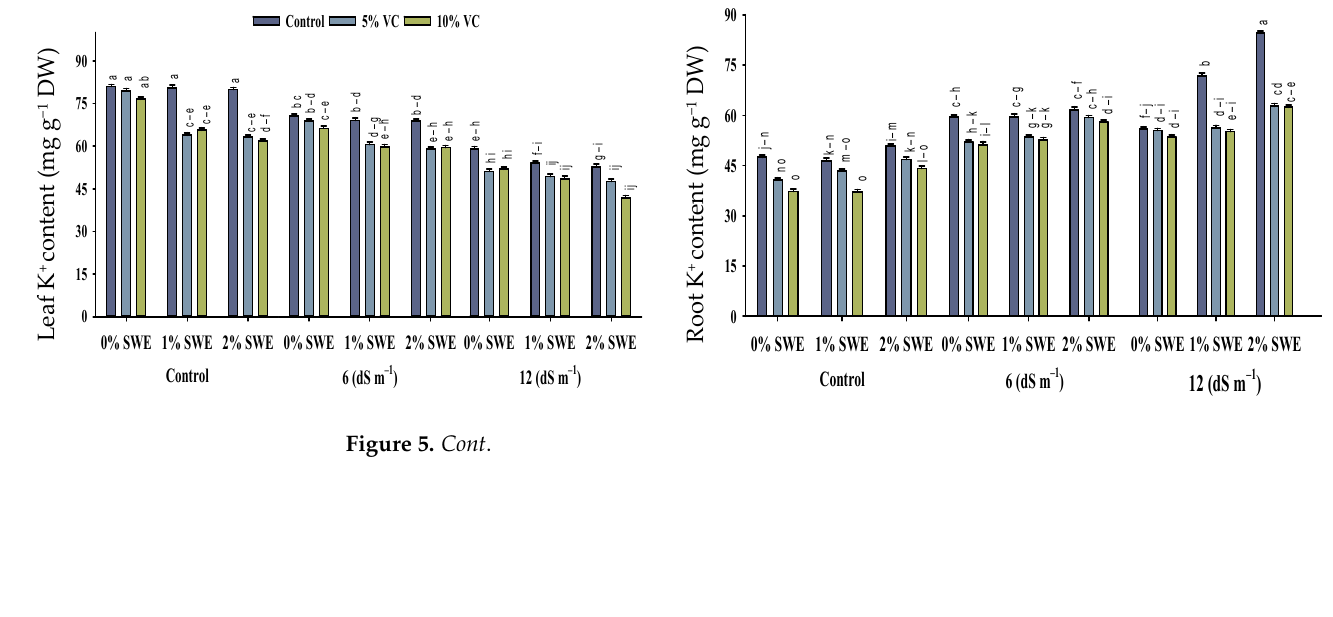
Salinity stress, vermicompost, and SWE treatment significantly impacted the concen- trations of Na + , K + , and the K + /Na + ratio in various parts of maize (Figure 5; Table 1). The interactive effects of vermicompost, SWE, and salinity (VC × SWE × S) on Na + and K + con- centrations and the K + /Na + ratio in the shoots and roots of maize were found to be statis- tically significant ( p ≤ 0.05). Salinity disturbed the ionic balance and significantly increased Figure 4. Hydrogen peroxide (H 2 O 2 ) (µmol g − 1 FW; a ) and malondialdehyde (MDA) (µmol g − 1 FW; Figure 4. Hydrogen peroxide (H 2 O 2 ) ( µ mol g − 1 FW; ( a ) and malondialdehyde (MDA) ( µ mol g − 1 FW; the accumulation of Na+ in plant parts compared to unstressed plants. While it decreased b ) contents in the leaf of maize as affected by various treatments of vermicompost (VC), sorghum ( b ) contents in the leaf of maize as affected by various treatments of vermicompost (VC), sorghum the K + concentration and K + /Na + ratio in maize shoots and roots, the highest reduction in water extract (SWE) under control, moderate salinity (6 dS m − 1 ), and high salinity (12 dS m − 1 ). Error water extract (SWE) under control, moderate salinity (6 dS m − 1 ), and high salinity (12 dS m − 1 ). K + concentration was observed in severe salinity. Error bars depict the standard error of 3 replications ( n = 3). Bars with the same letters do not differ bars depict the standard error of 3 replications ( n = 3). Bars with the same letters do not differ sig- significantly ( p ≤ 0.05). nificantly ( p ≤ 0.05).